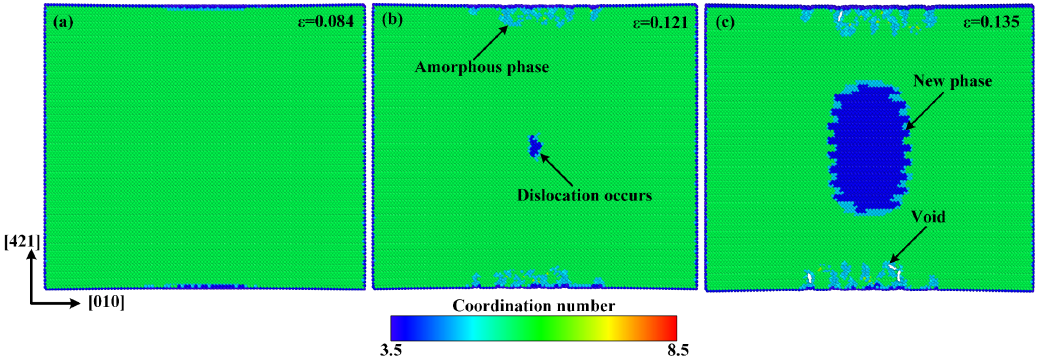
Figure 4. Atomic configurations when the tensile strain along the [ 010 ] direction reaches: ( a ) ε = 0.084, ( b ) ε = 0.121, and ( c ) ε = 0.135. The atoms are colored according to the coordination number of Ca with green for calcite, blue for the new phase, and cyan for the amorphous phase.